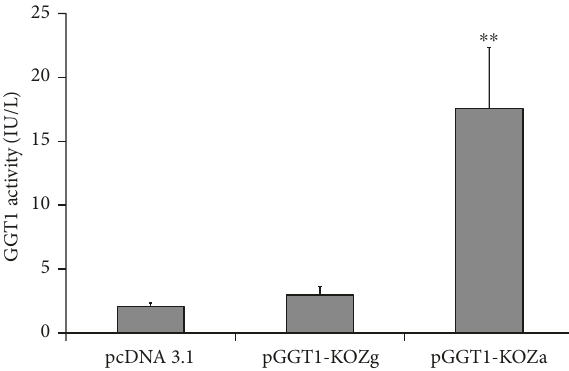
Figure 1: Expression of GGT1 in COS7 cell lines. ∗∗ P < 0 001